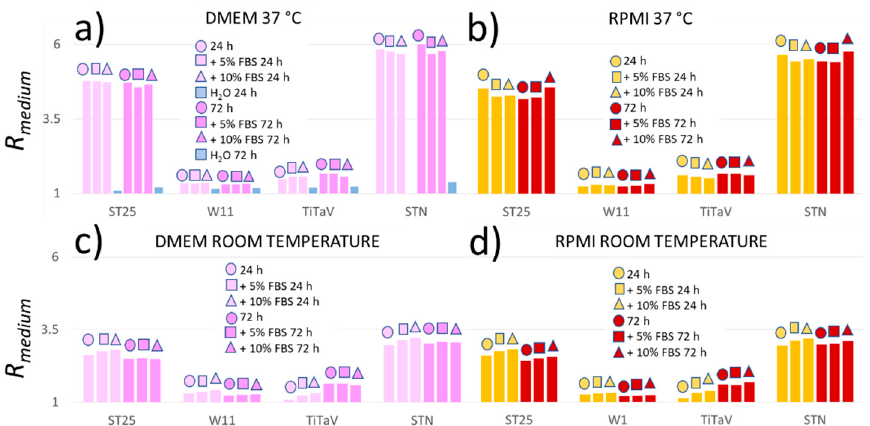
Figure 7. Sensor responses to different culture media. ( a ) R m amplitude to DMEM only, DMEM supplemented with 5% or 10% FBS, and ultrapure water measured 24 or 72 h after withdrawal from the incubator at 37 ◦ C; ( b ) R m amplitude to RPMI only, RPMI supplemented with 5% or 10% FBS, at 37 ◦ C 24 or 72 h after withdrawal from the incubator; ( c ) same responses of ( a ) but at room temperature; ( d ) same response of ( b ) but at room temperature.